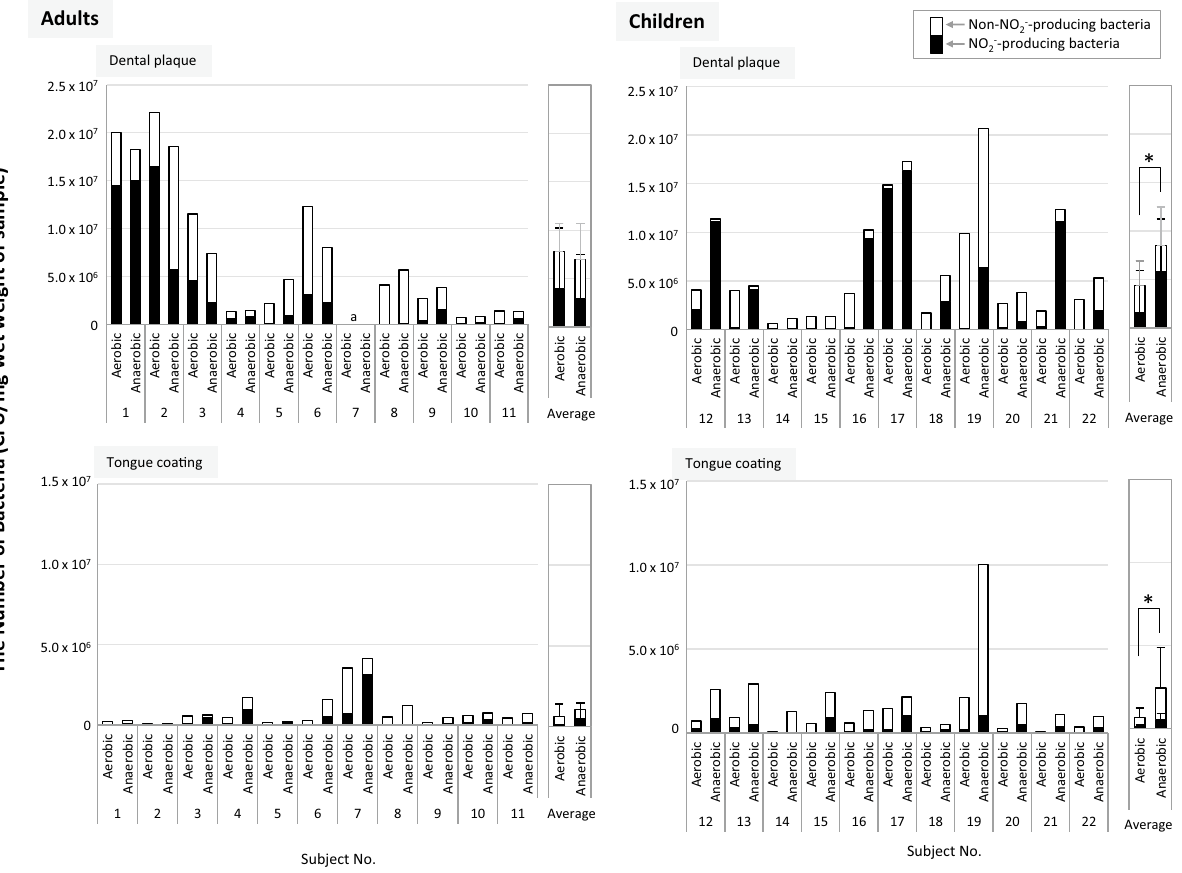
Figure 2. The numbers of NO 2 − -producing and non-NO 2 − -producing bacteria detected in dental plaque and tongue-coating samples cultured under aerobic and anaerobic conditions (CFU/mg wet weight of sample). Subject numbers: 1–11 (adults), 12–22 (children); Aerobic: the bacteria on the blood agar plate were cultured aerobically; Anaerobic: the bacteria on the blood agar plate were cultured anaerobically; *significant difference (p < 0.05); a: not available because the wet weight of the sample was below the detectable